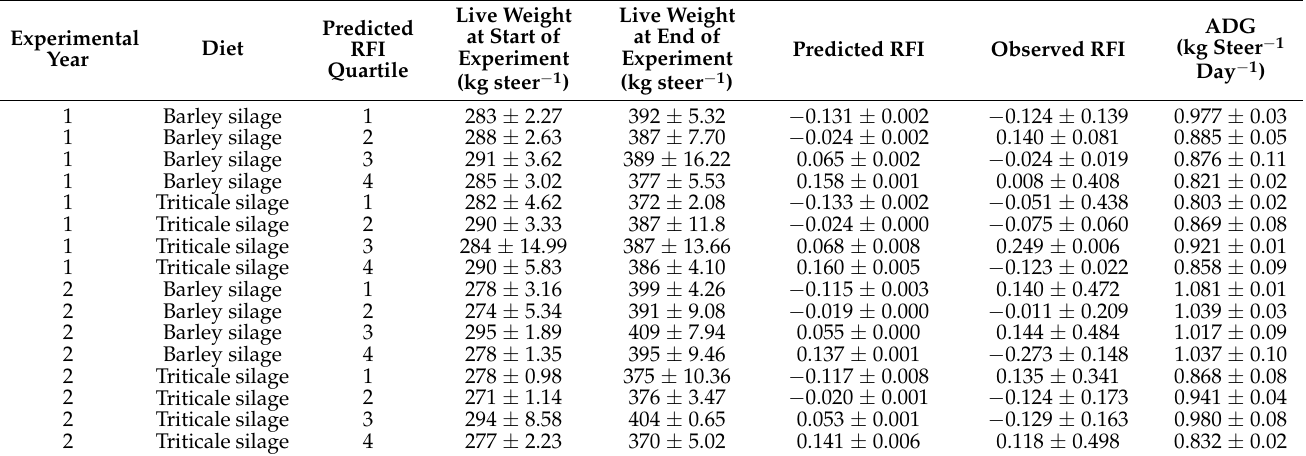
Table 1. Means and standard deviation ( ± SD) for live steer weight, predicted and observed residual feed intake (RFI), and steer average daily gain (ADG) for diet treatments over the two-year